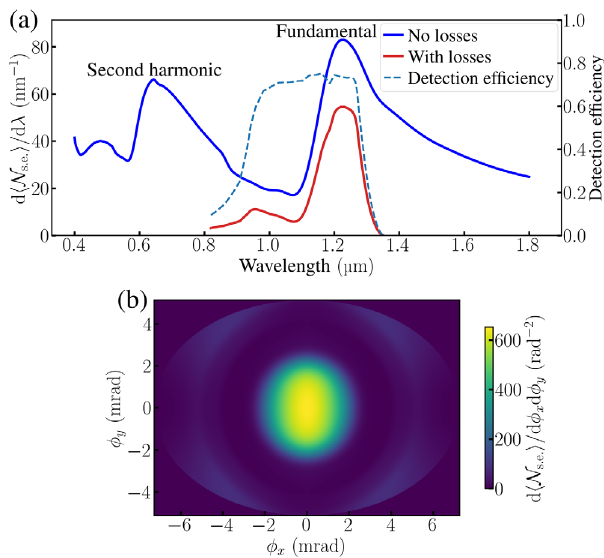
FIG. 3. (a) Spectral distribution of the average number of detected photons per turn for a single electron (s.e.) assuming no losses (blue) and accounting for the detection efficiency of the system (red). Also, the detection efficiency (dashed, right vertical scale). (b) Angular distribution of the number of detected photons accounting for the detection efficiency of our system. Both (a) and (b) are calculated for an elliptical aperture with the horizontal and the vertical semiaxes 7.3 mrad and 5.1 mrad, respectively.